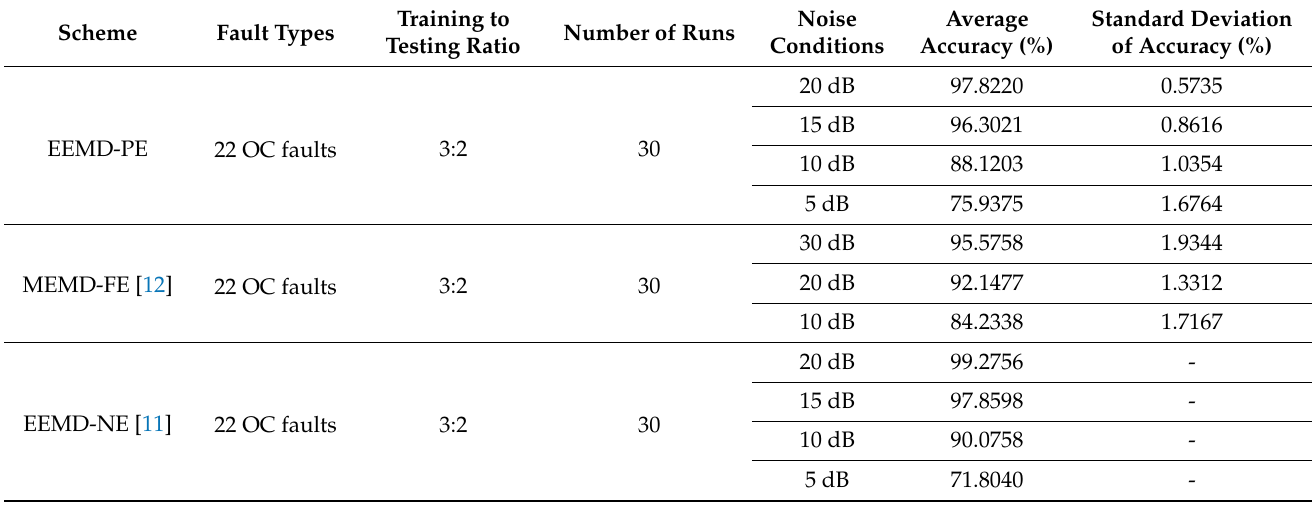
Table 6. Comparison with previous